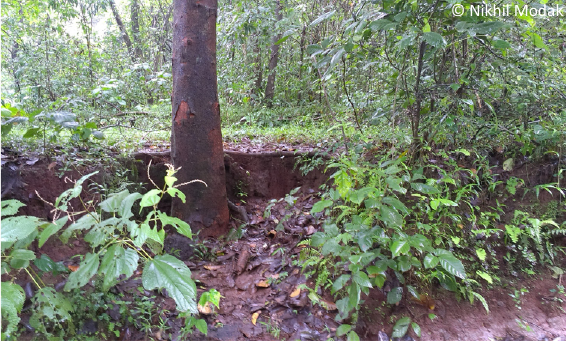
Image 6. Microhabitat at the type locality at Tanshikar Spice Farm.